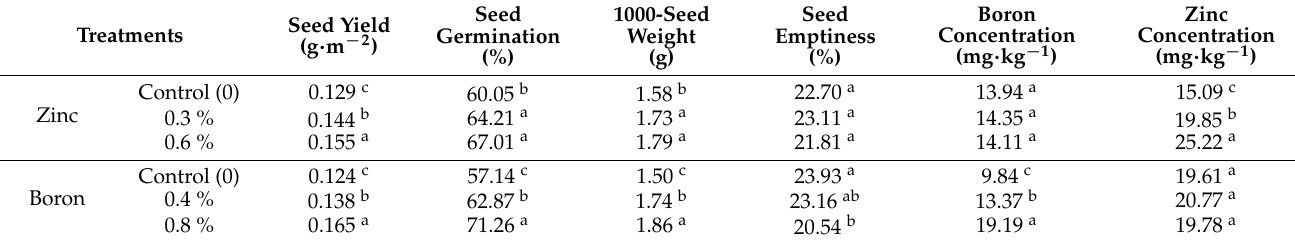
Table 4. Mean comparison of the simple effects of boron and zinc foliar application on seed traits and B and Zn contents of the leaf of S. khuzistanica in the first year of the experiment.